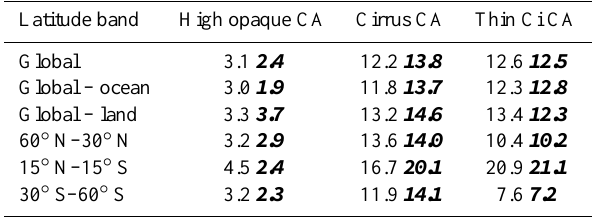
Table 4. Cloud amount (CA) of high opaque clouds ( p cld < 440hPa and ε cld > 0.95), cirrus ( p cld < 440hPa and 0.5 >ε cld > 0.95), and thin cirrus ( p cld < 440hPa and ε cld < 0.5), from the AIRS-LMD cloud climatology. For comparison, results are shown in italic from the TOVS Path-B cloud climatology (1987–1995). Averages are pre- sented over the globe, separately over ocean and over land, and